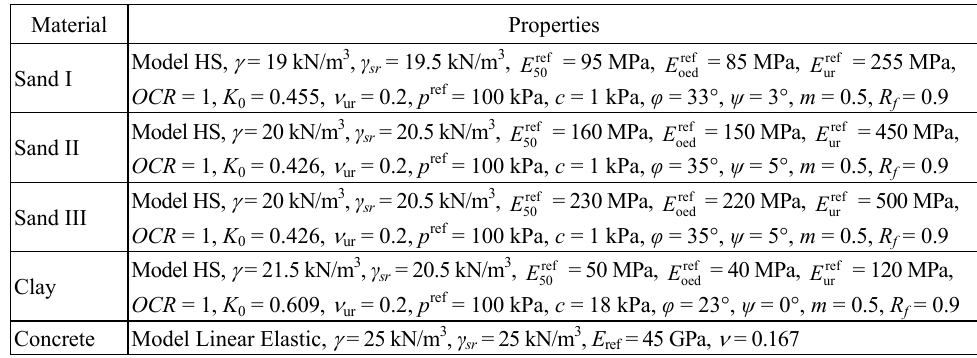
Table 2. Material properties used for numerical simulations in Plaxis